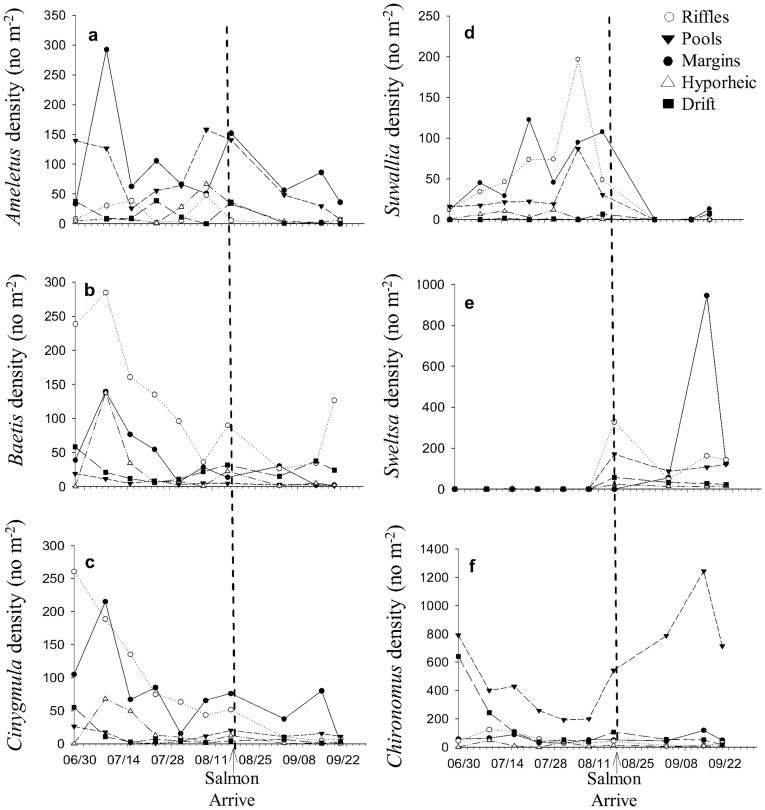
Genus-level differences throughout the salmon run.Densities of the six dominant taxa: Ameletus (a), Baetis (b), Cinygmula (c), Suwallia (d) Sweltsa (e) and Chironomus (f) throughout the salmon run in riffles, pools, margins, the hyporheic zone and drift.